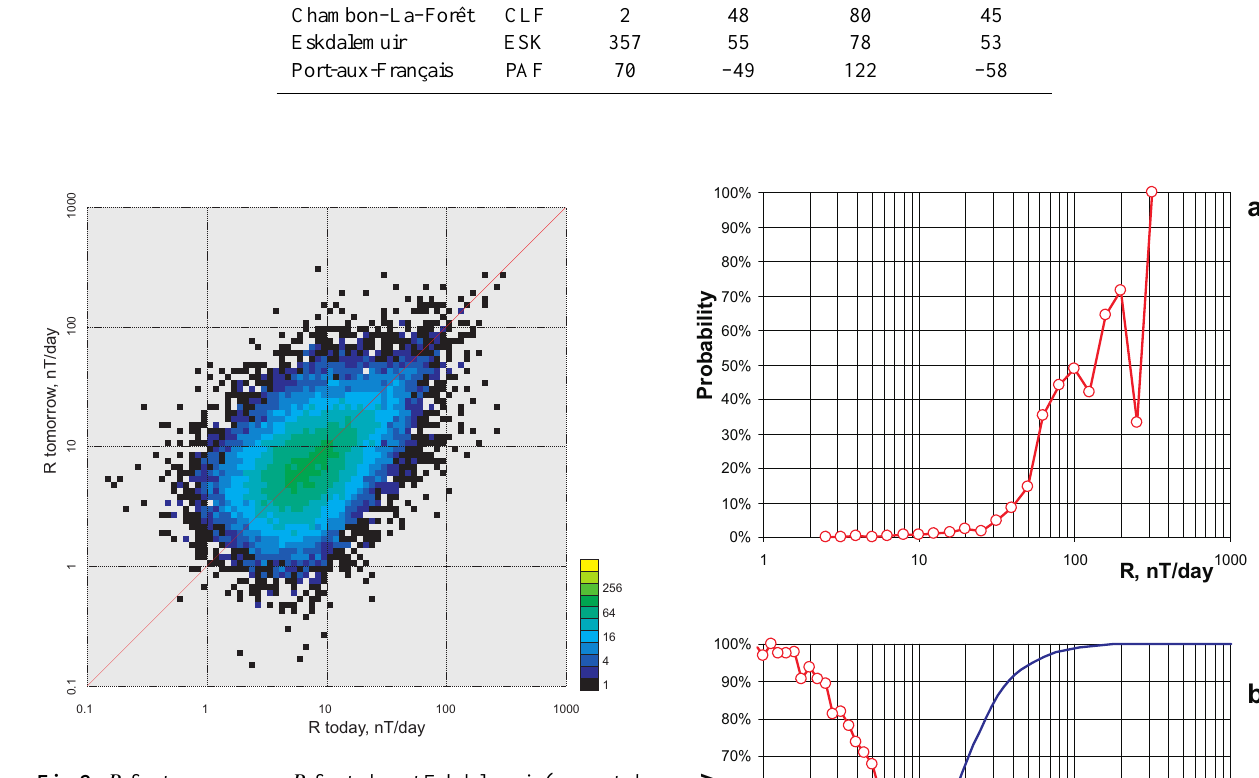
Fig. 2. R for tomorrow vs. R for today at Eskdalemuir (computed from daily means): 2-D histogram. The color indicates the number of pairs in a cell, see color bar.